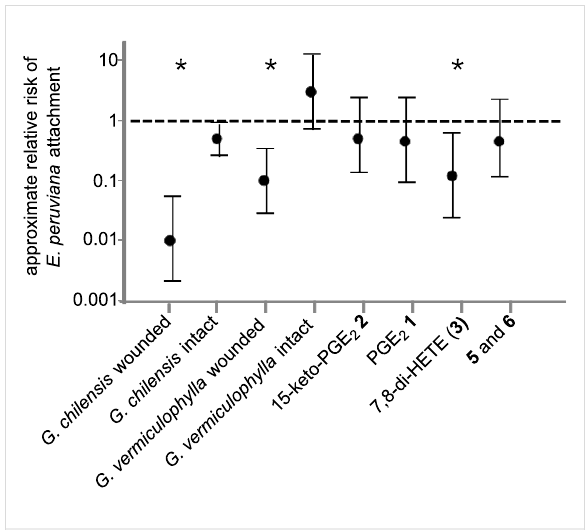
Figure 2: Relative risk (mean ± 95% confidence interval) of Echinolit- torina peruviana attachment on surfaces treated with Gracilaria chilensis and Gracilaria vermiculophylla extracts obtained before and after wounding. In addition, the relative risk of attachment to pure com- pounds in natural concentrations is given. Asterisks indicate signifi- cant effects when examined with the χ ²-test, as described in Fisher and van Belle